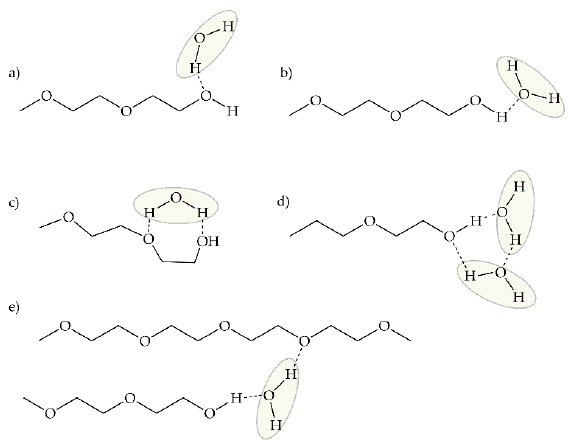
Figure 11. Proposed structure of water at the end of an hydrated PEG chain (peak X) as shown in